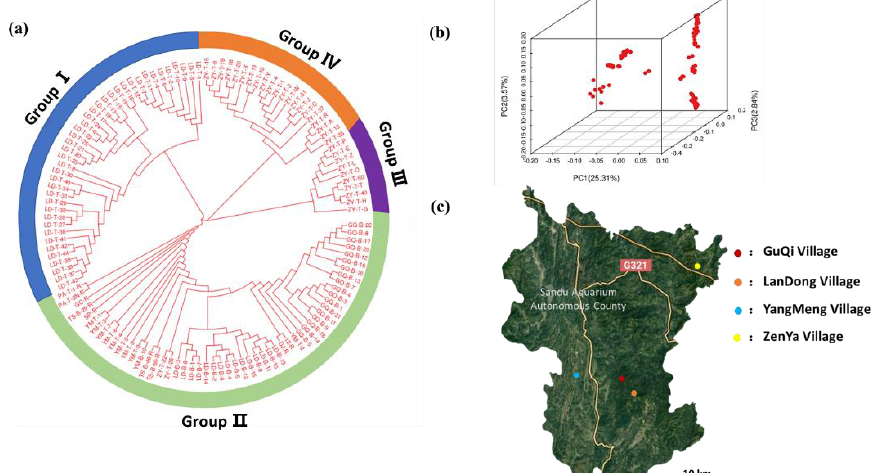
Figure 5. Phylogenetic tree analysis, principal component analysis, and four ancient tea-producing areas in Sandu County. ( a ) Phylogenetic tree analysis of 125 ancient tea plants. Each branch represents an ancient tea plant. The 125 ancient tea plants were also presented in Table 1. ( b ) Principal component analysis of 125 ancient tea plants. PCA three-dimensional cluster diagram of 125 ancient tea plants showing PC1 (first principal component), PC2 (second principal component), and PC3 (third principal component). A dot represents an ancient tea plant. ( c ) The location map of four ancient tea plant-producing areas in Sandu County. The red dot represents Guqi Village, the orange dot represents Lankan Village, the blue dot represents Yangmeng Village, and the yellow dot represents Zenya Village.